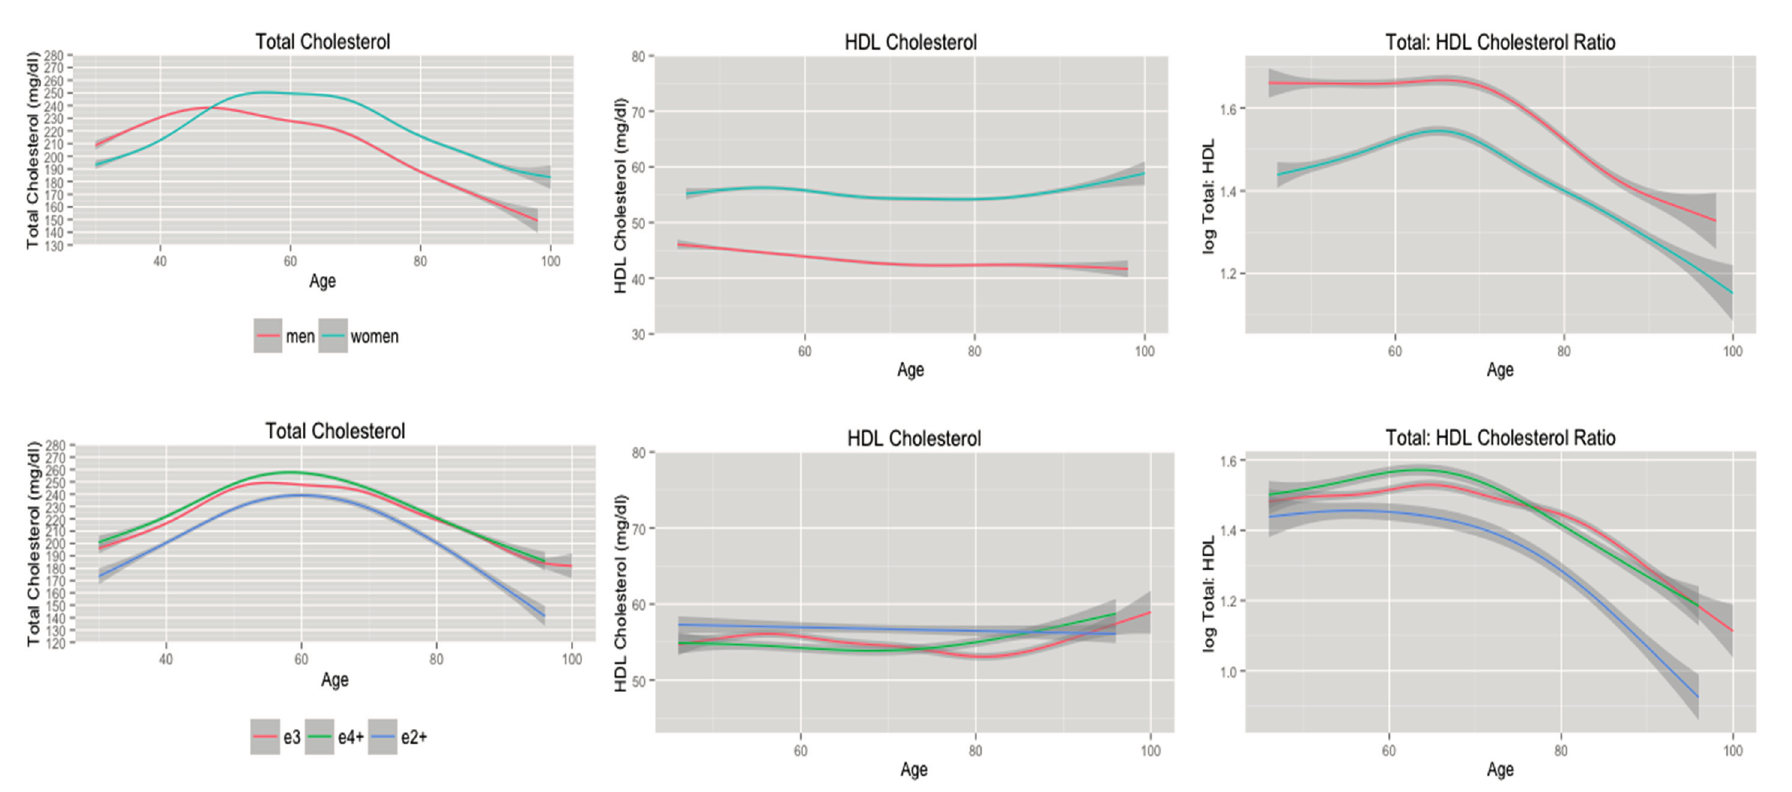
Figure 3. Cholesterol trajectories stratified according to gender, and APOE allele status adjusting for age of menopause, use of supplemental estrogen, and cause of menses